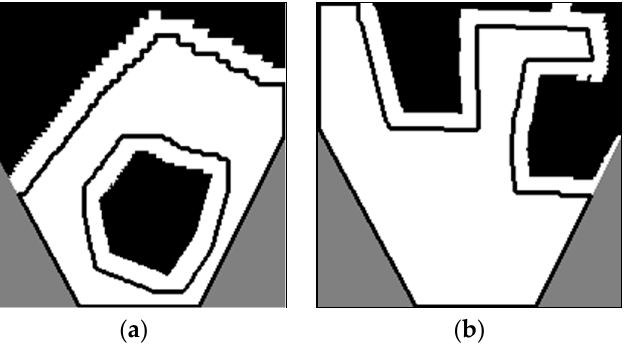
Figure 16. Determine the bounding of the collision-free area: ( a ) having one obstacle at the bottom of the environment, ( b ) having two obstacles at the top of the environment.